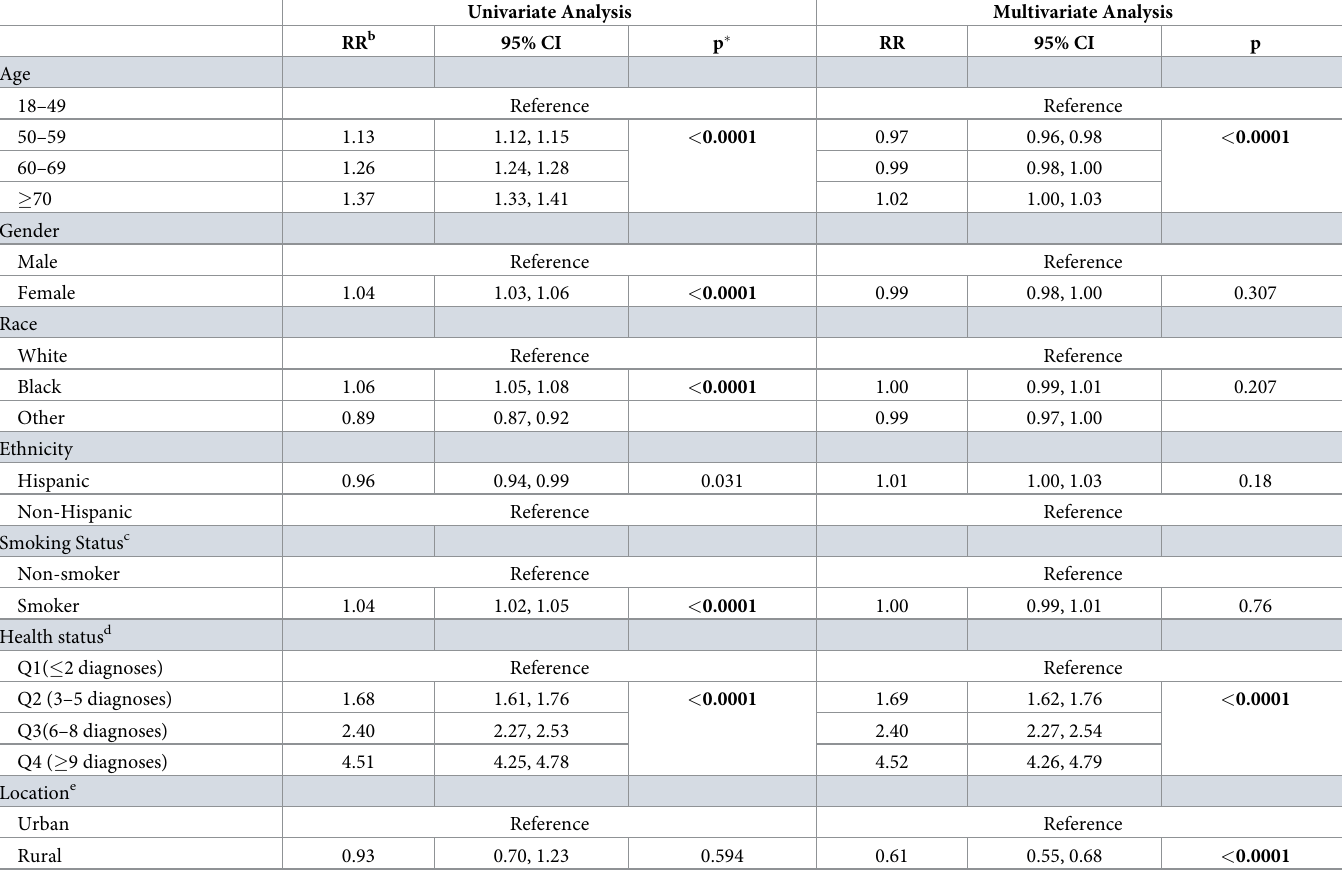
Table 4. Association of patients characteristics and healthcare utilization: Univariate and multivariate